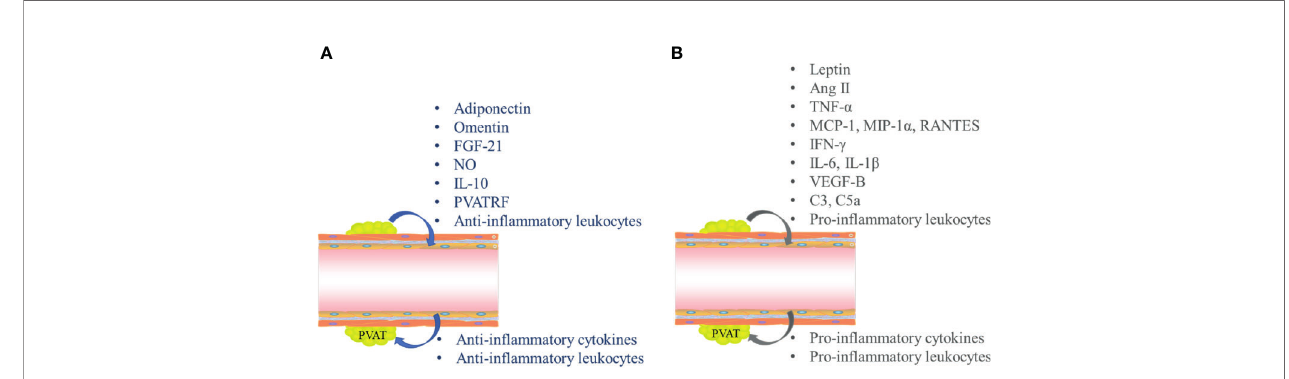
FIGURE 1 | Secretory functions mediate in fl ammatory crosstalk between perivascular adipose tissue (PVAT) and blood vessels. (A) Interactions between PVAT and blood vessels in normal physiological conditions. (B) Crosstalk between PVAT and blood vessels in pathological conditions. FGF-21, fi broblast growth factor-21; NO, nitric oxide; IL, interleukin; PVATRF, PVAT-derived relaxing factor; TGF- b 1, transforming growth factor- b 1; Ang II, angiotensin II; TNF- a , tumor necrosis factor- a ; MCP-1, monocyte chemoattractant protein-1; MIP-1 a , macrophage in fl ammatory protein 1 a ; IFN- g , interferon g ; VEGF-B, vascular endothelial growth factor